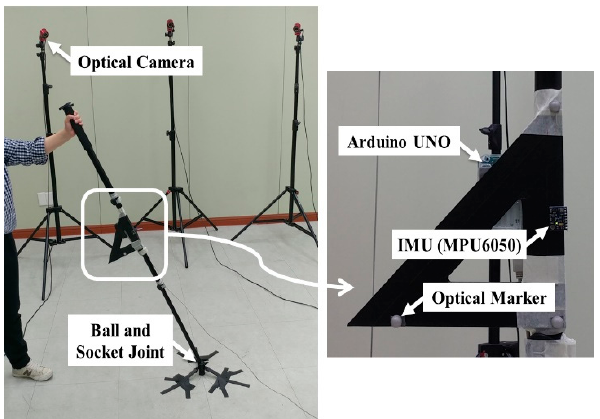
Figure 3. Experimental setup: An IMU and optical markers attached to a link constrained by a ball-and-socket joint.